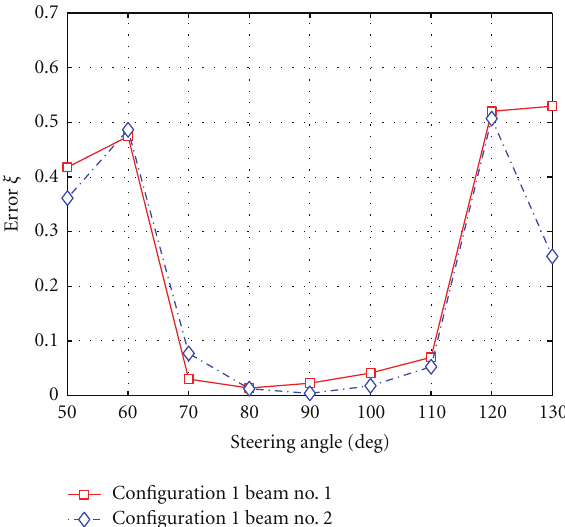
Figure 8: Amplitude distribution and antenna element location for the reference factor (CORPS-BFN) and the reconstructed factor (MPM + CORPS-BFN) for the beam no. 1 shown in Figure 4.